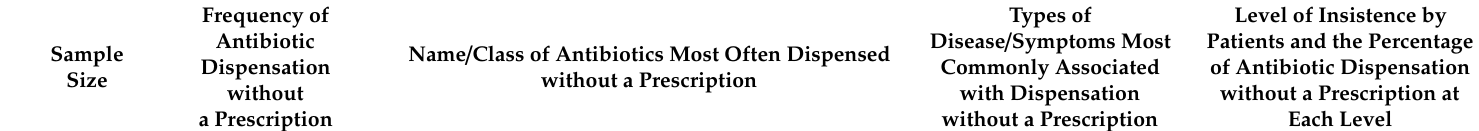
Table 2. Study Outcomes—Articles that use the simulated patient